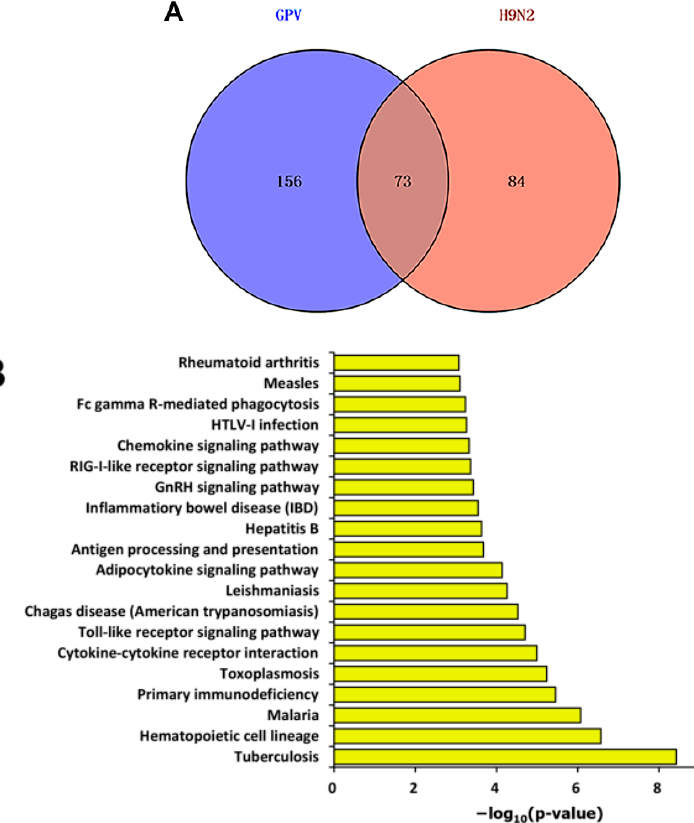
Figure 3. Co-immune relevant unigenes of the two virus-infected groups. ( A ) The Venn diagram shows the numbers of immune relevant unigenes that were either unique or shared between the GPV- and H9N2-infected groups; and ( B ) KEGG enrichment analysis of co-immune relevant unigenes of the two virus-infected groups.